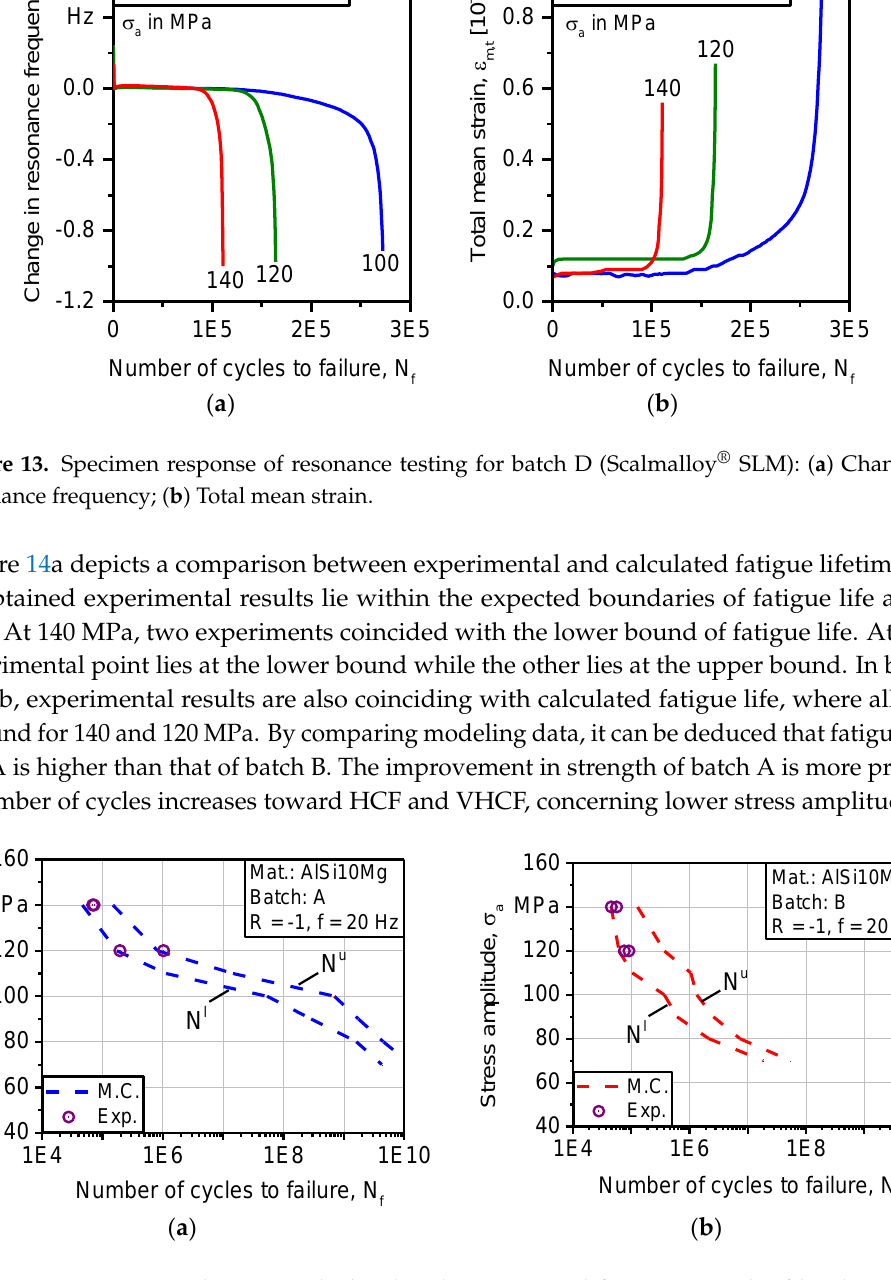
Figure 14. Comparison between calculated and experimental fatigue strength of batches: ( a ) A (AlSi10Mg 0°); ( b ) B (AlSi10Mg 90°).